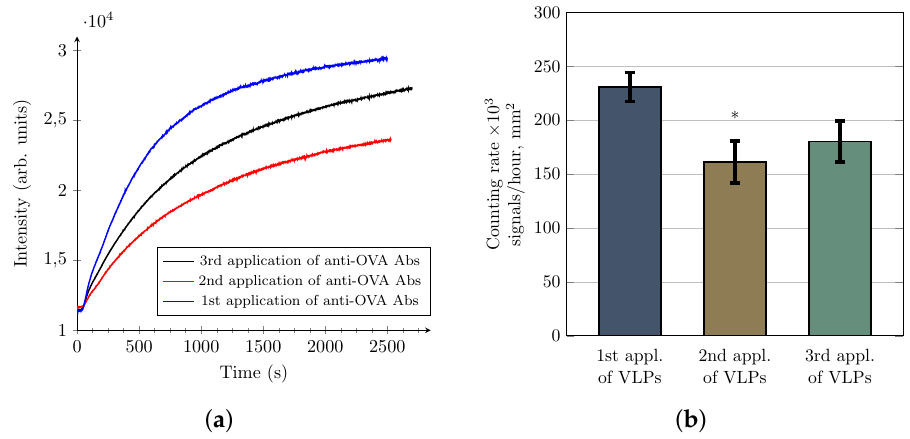
Figure 5. Changes of virus-like particle (VLP) counting rates after repeated use of the same gold sensor were investigated. Sensor surface is functionalized with cysteine-conjugated protein A/G and further covered with anti-ovalbumin antibody. After the first coverage with antibody and a measurement of VLP counting rate, an elution of antibody layer is performed. Then, after recovery with Phosphate-buffered saline (PBS) buffer, the second time coverage with anti-ovalbumin antibody and again a measurement of VLP counting rate are carried out. This cycle is repeated the third time. Three independent experiments were performed. The efficiency of antibody binding to the sensor surface is monitored and data are presented on the graph ( a ). The typical monitored antibody binding curves are displayed (for one experiment from three performed). Counting rates of HIV-VLPs are presented on the graph ( b ). Statistical analysis was performed using Student’s t -test. Significance was set at p < 0.05 and marked with symbol “*” (significant difference between the first application of VLP and the second). ( a ) antibody binding efficiency; and ( b ) HIV-VLP counting